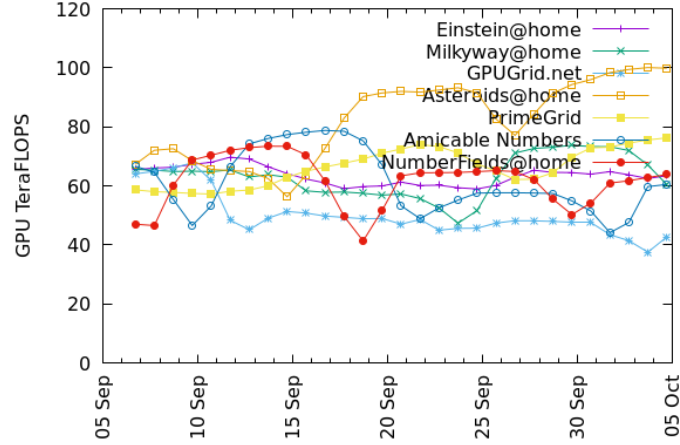
Figure 4. GPU throughput of the top 10 projects in 2020.